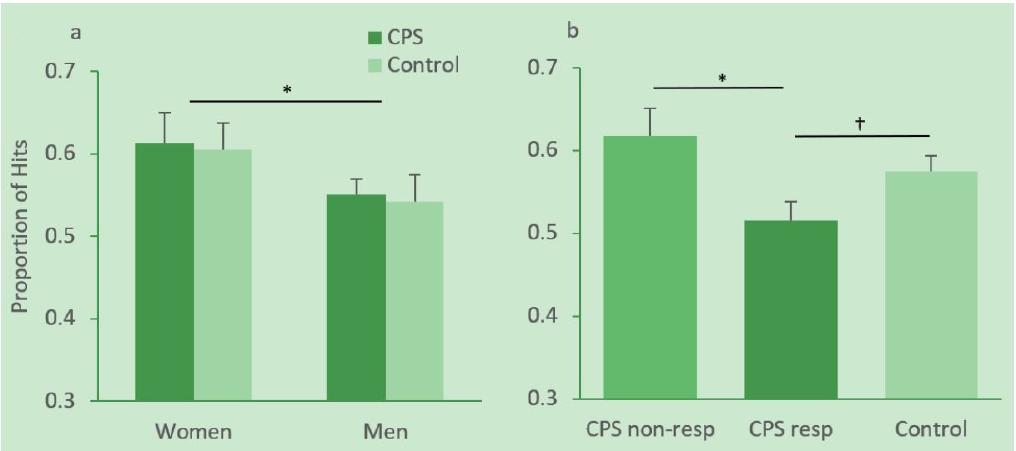
Figure 4. Proportion of hits for men and women in the cold pressor stress (CPS) and control group ( a ) and in CPS responders, non-responders and the control group ( b ). Error bars represent standard errors of means. * significant at the 0.05 level, † marginally significant .